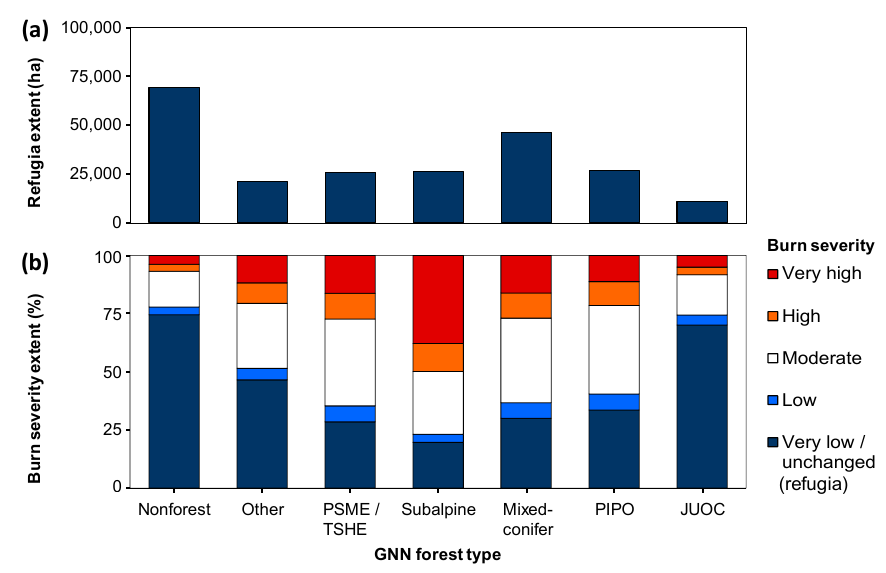
Figure 7. Forest composition of fire refugia in terms of extent of refugia ( a ) and relative distribution of other burn severity classes ( b ). Mixed-conifer forests in relatively dry parts of the region were the most extensive forest type and contained the most refugia ( a ). The percentage of refugia was lowest in subalpine forests and highest in juniper woodlands ( b ). Pre-fire forest types are consolidated into general forest types, ordered from west to east, and are based on live basal area of dominant tree species according to 2003 GNN maps [38]. See Section 2 for details regarding burn severity and forest-type classification and Figures 3 and 4 for landscape spatial patterns. We include non-forested areas for reference but do not interpret the severity classes in direct comparison with the forested areas.